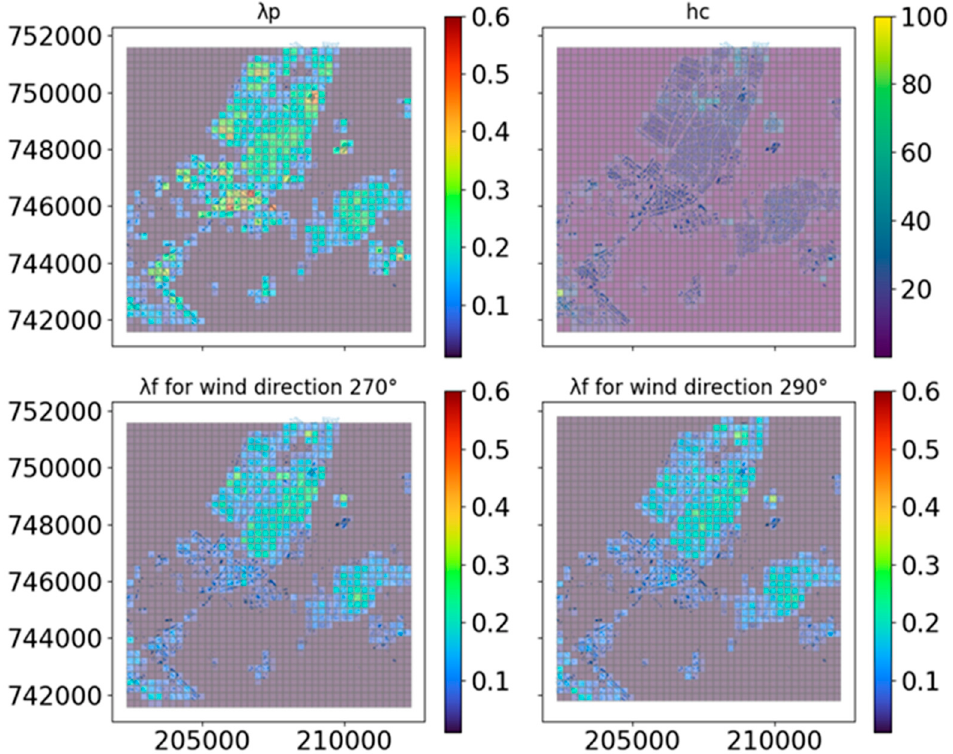
Figure 2. A map of the morphological parameters: the ratio of the occupied and total plan area, λ p [decimal number] ( upper left panel ), the plan area weighted average building height, h c [meters] ( upper right panel ) and the frontal area density ratio, λ f , for wind direction of 270 ◦ ( lower left panel ) and 290 ◦ ( lower right panel ). The map coordinates are expressed in ITM (the Israeli Transverse Mercator coordinate system).